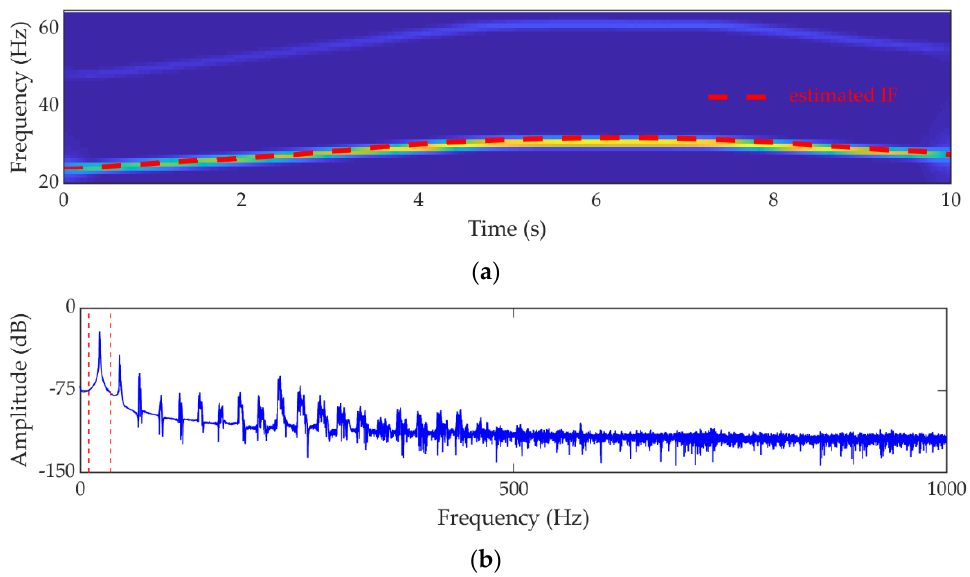
Figure 11. ( a ) The IF estimated by PIFEM compared with the TFR generated by STFT; ( b ) the amplitude spectrum of the signal after resampling.